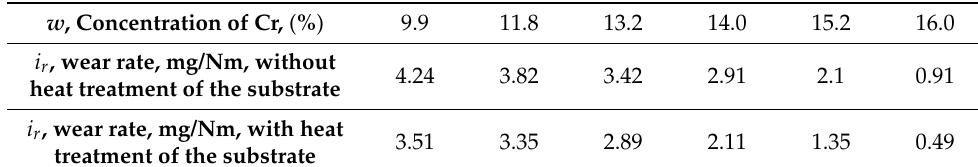
Table 5. Wear rate at different chromium concentration, %.